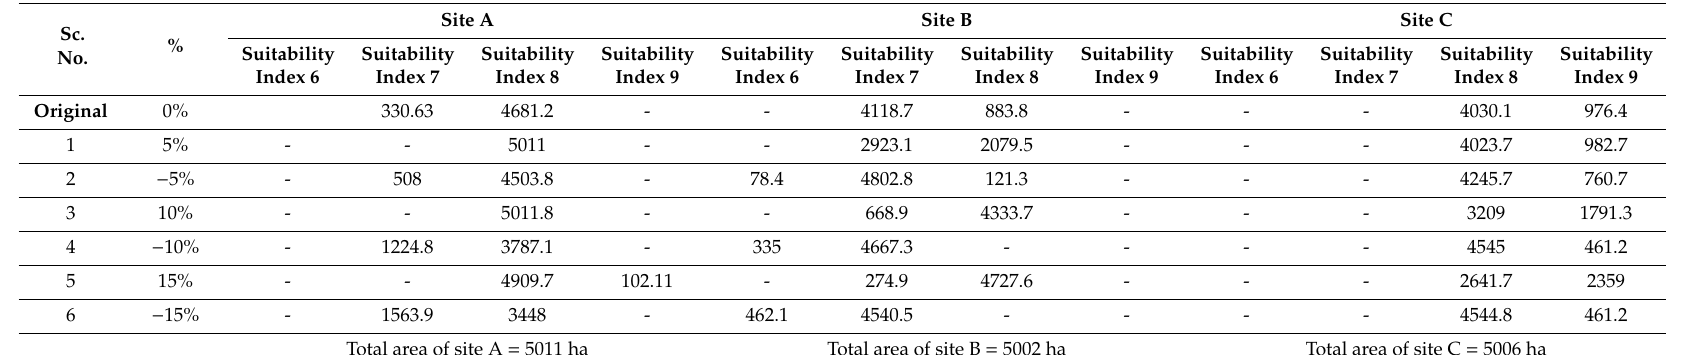
Table 15. Areas of candidate sites for six